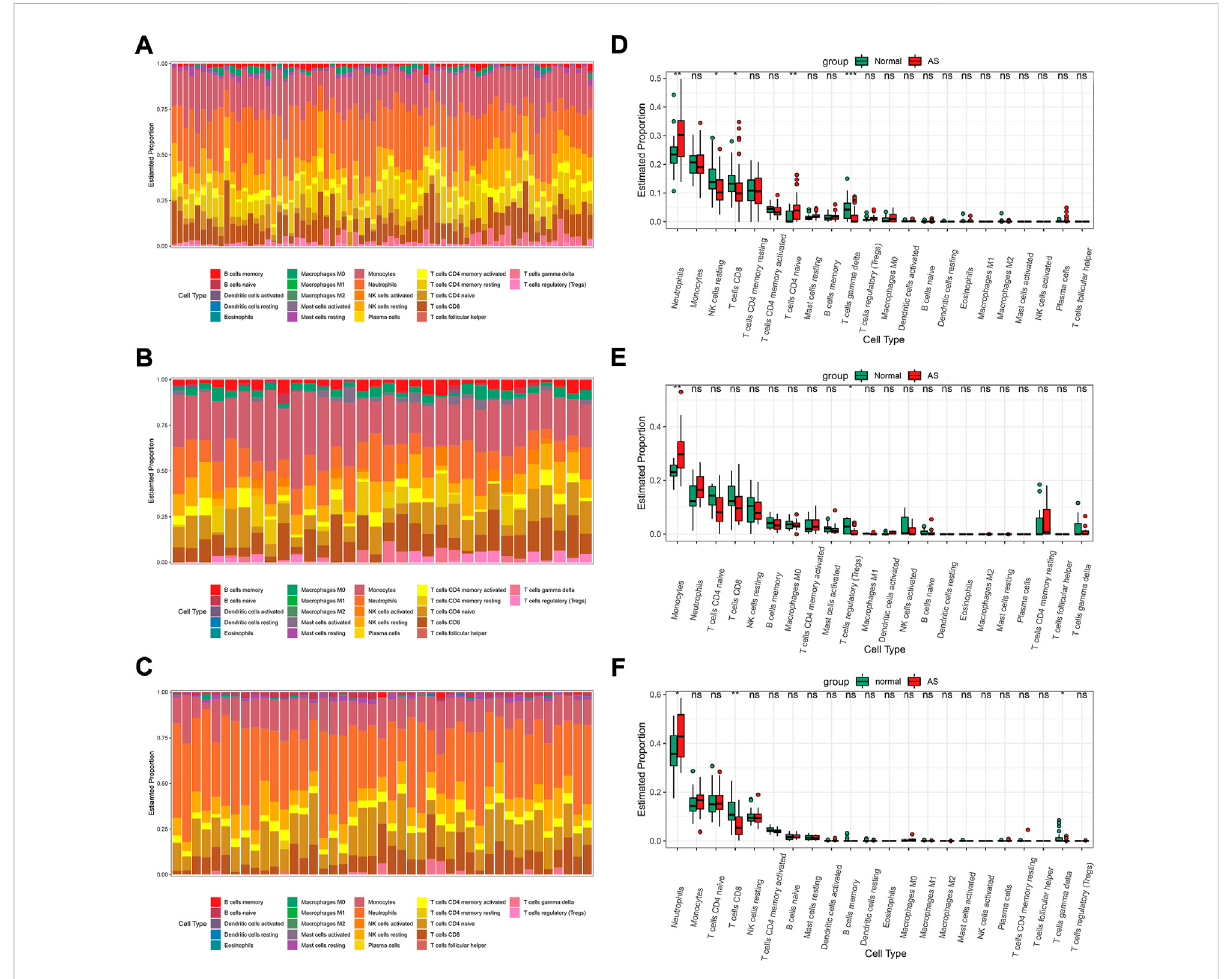
FIGURE 5 The IME analysis of the sets by CIBERSORT. The proportion of the 22 immune cells for samples in GSE73754 (A) , GSE25101 (B) , and GSE18781 (C) . Boxplots for the 22 immune cells between normal people and AS patients in GSE73754 (D) , GSE25101 (E) , and GSE18781 (F) (p signi fi cance level: no signi fi cance (ns), p ≥ 0.05; *, p < 0.05; **, p < 0.01; ***, p < 0.001; ****, p <